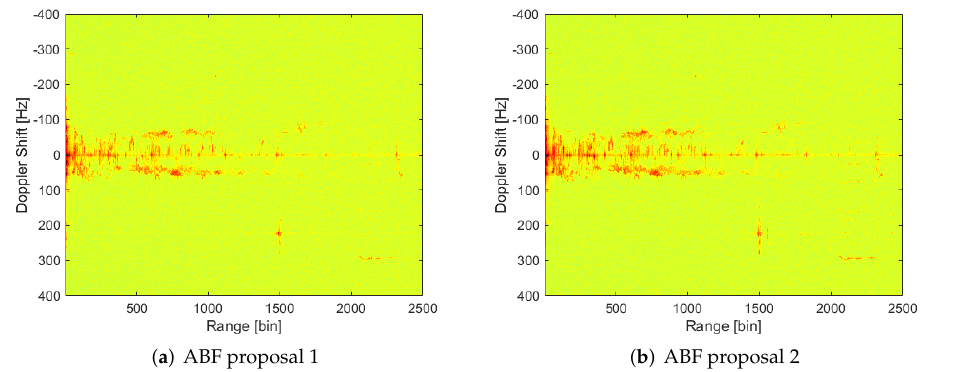
Figure 12. RD map of CPI 13 with adaptive weigths through MVDR algorithm and employing the two proposals for interference covariance matrix estimation.